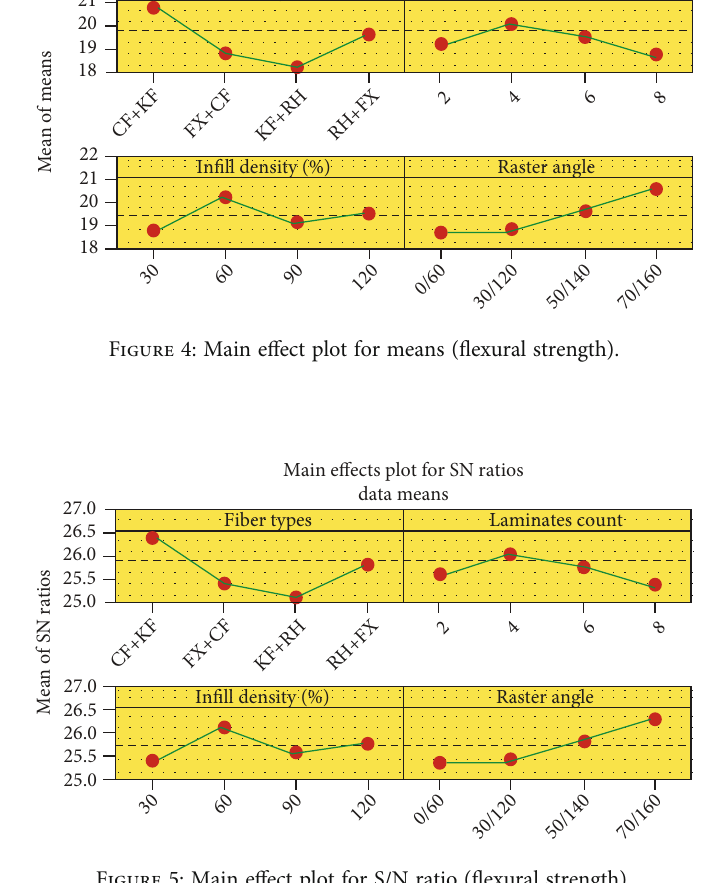
Figure 5: Main e ff ect plot for S/N ratio ( fl exural